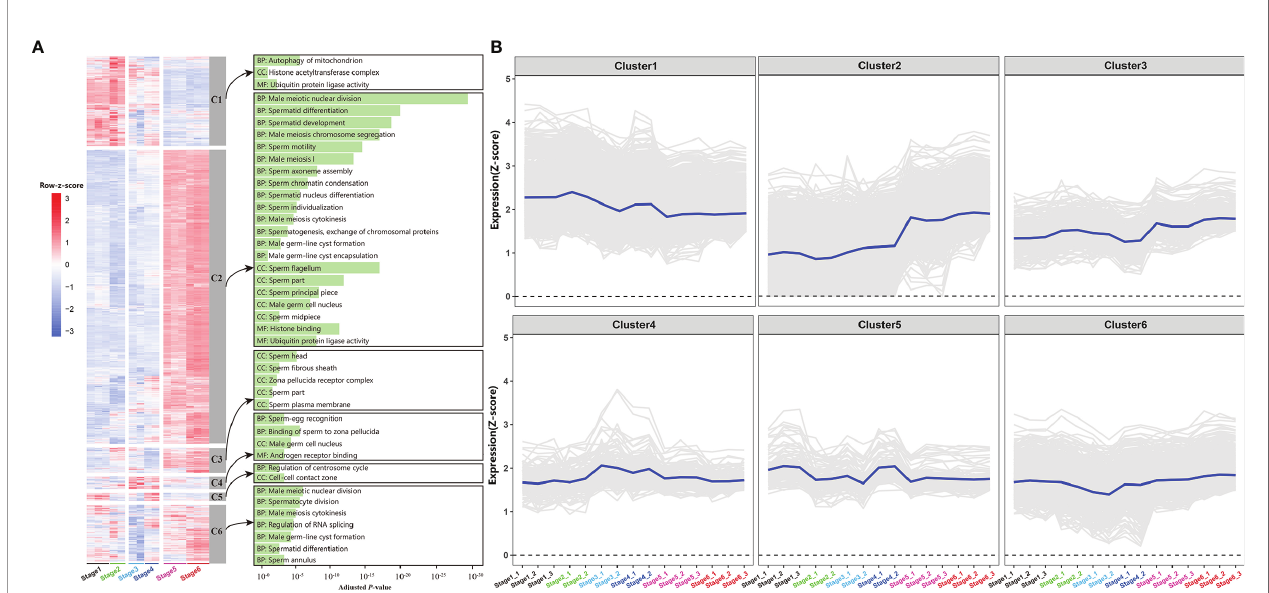
FIGURE 5 | Clustering of expression pro fi les in the gonad. (A) Heatmap of six expression clusters across gonad development. The bar plots on the right display selected GO enrichment of relevant clusters. BP, biological process; CC, cell component; MF, molecular function. (B) Time-series expression pro fi le of six clusters. The blue represents the average expression of the cluster, and the background lines represent all genes assigned to this cluster. The expression values were represented by